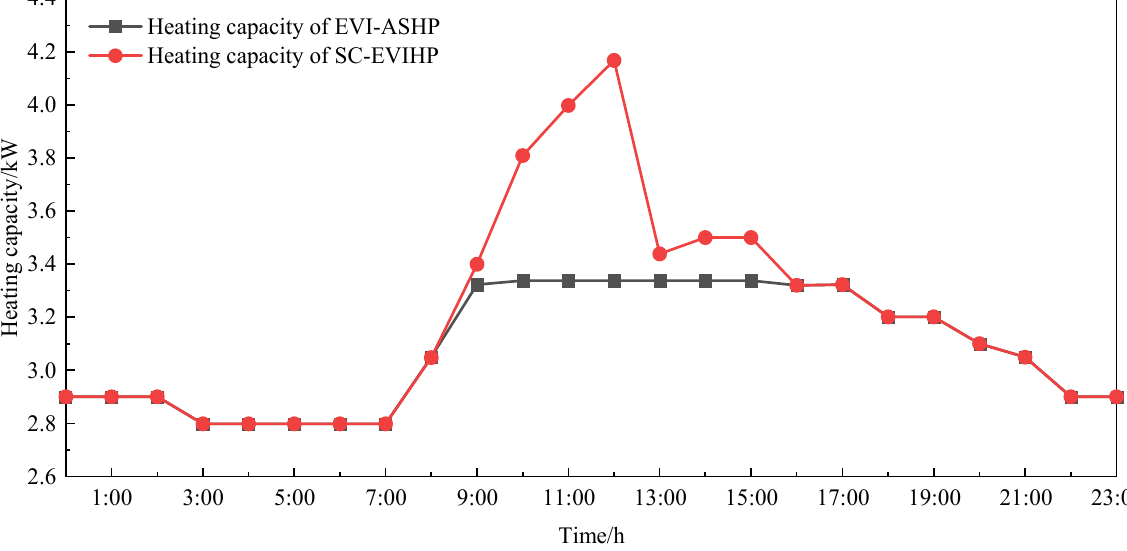
Figure 7. Comparison of heating capacity of the systems.